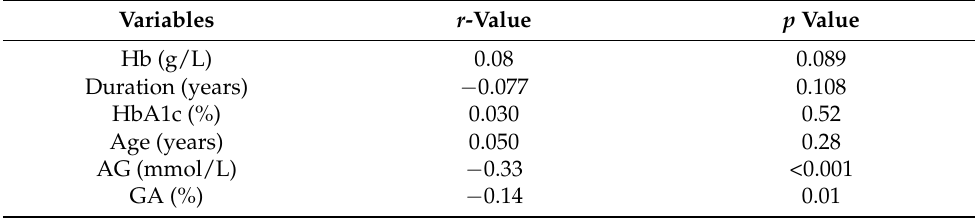
Table 2. The correlation between the RBC lifespan and variables of T2DM.